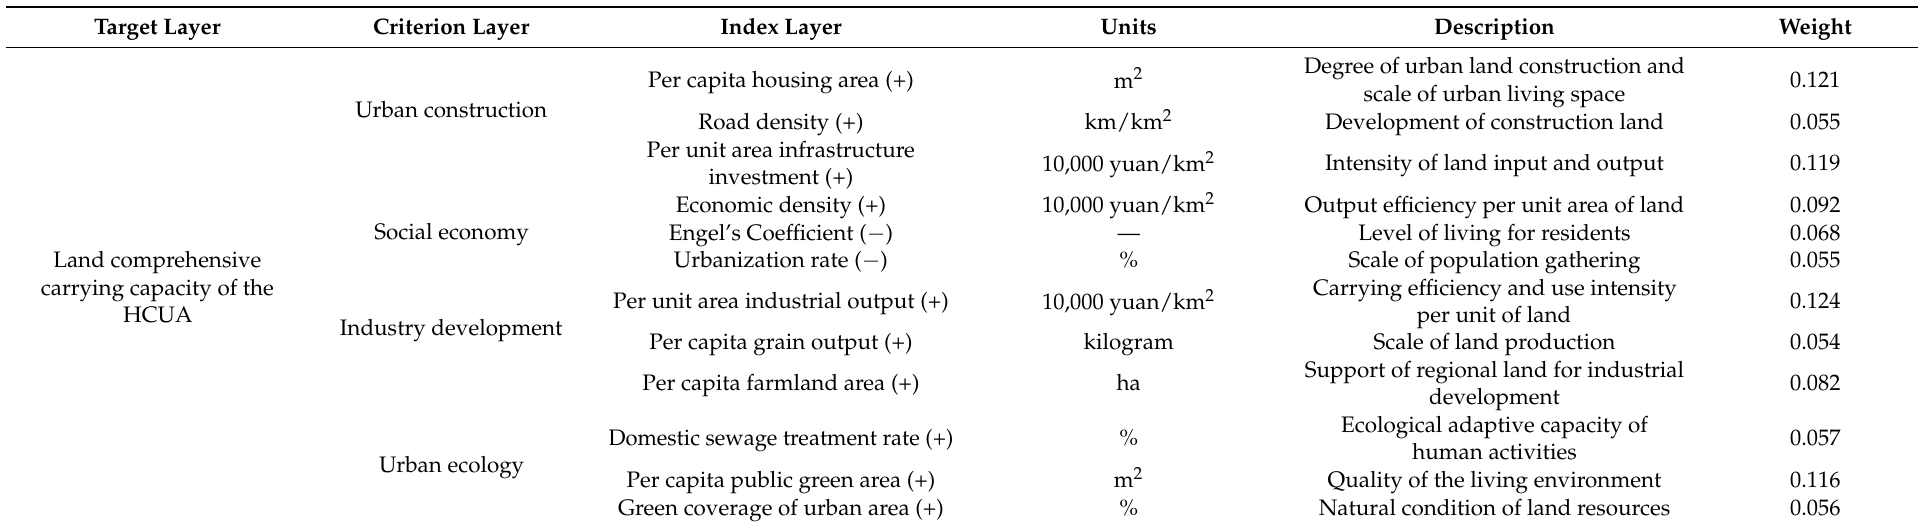
Table 2. Evaluation index system of